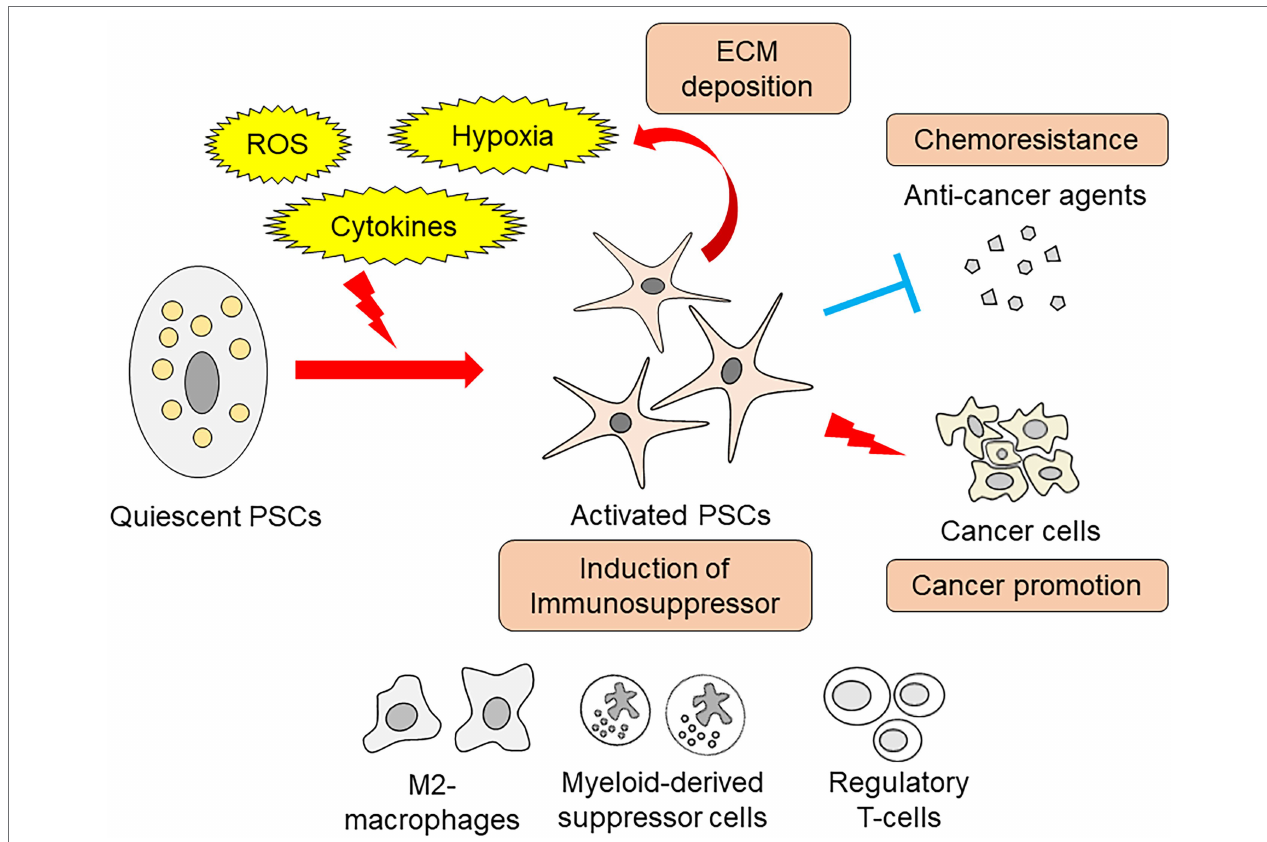
FIGURE 1 | Schema of PSCs roles in pancreatitis and pancreatic